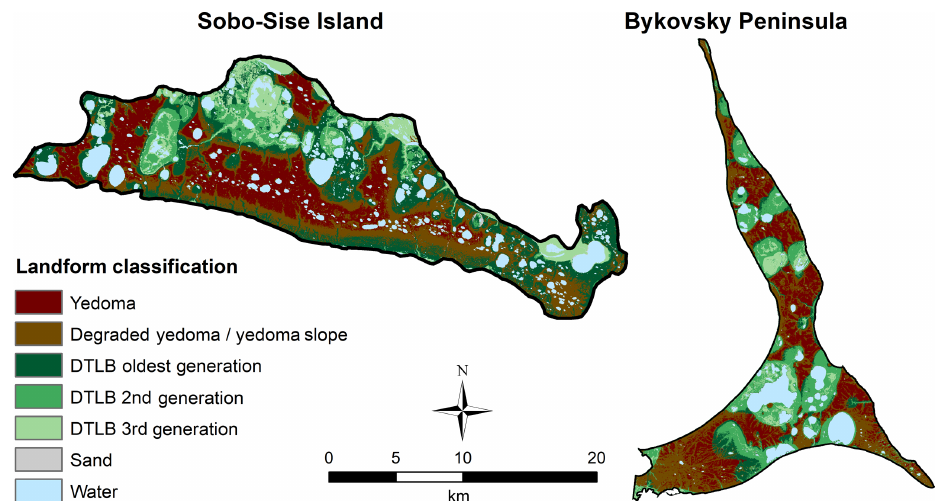
Figure 5. Landform classification of Sobo-Sise Island and Bykovsky Peninsula. For upscaling, the three classes of DTLB generations were merged into one single thermokarst